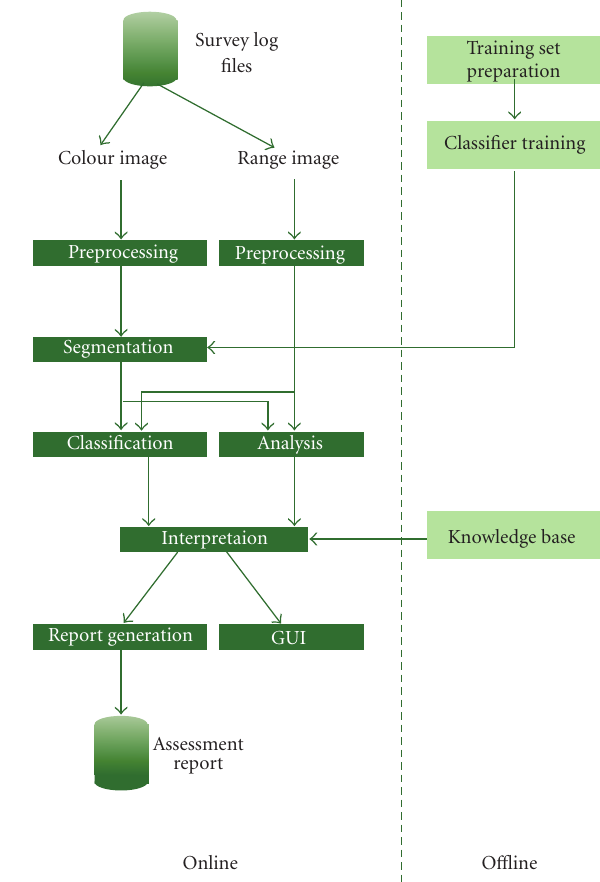
Figure 4: Schematic diagram of proposed